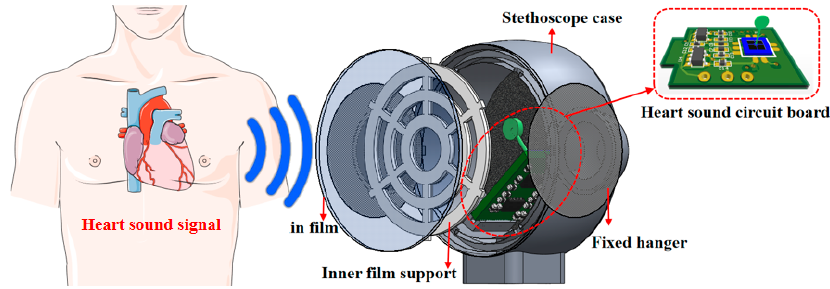
Figure 6. MEMS cardiac sound sensor acoustic encapsulate matching diagram. Table 3. Acoustic velocity values and characteristic acoustic impedances in varying media.